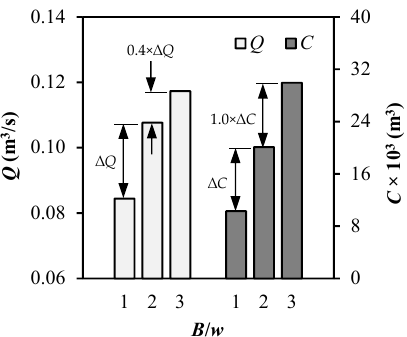
Figure 22. PKW discharge ( Q ) and body volume ( C ) versus B / w : ( H o / P = 0.5, A / w = 0.25).